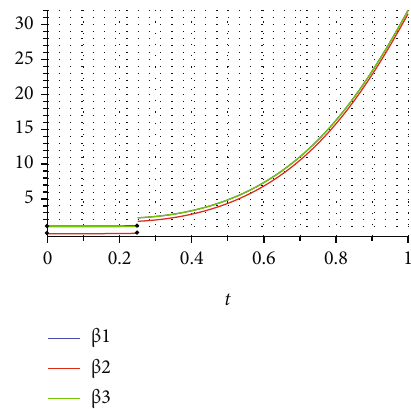
Figure 2: Graphs in